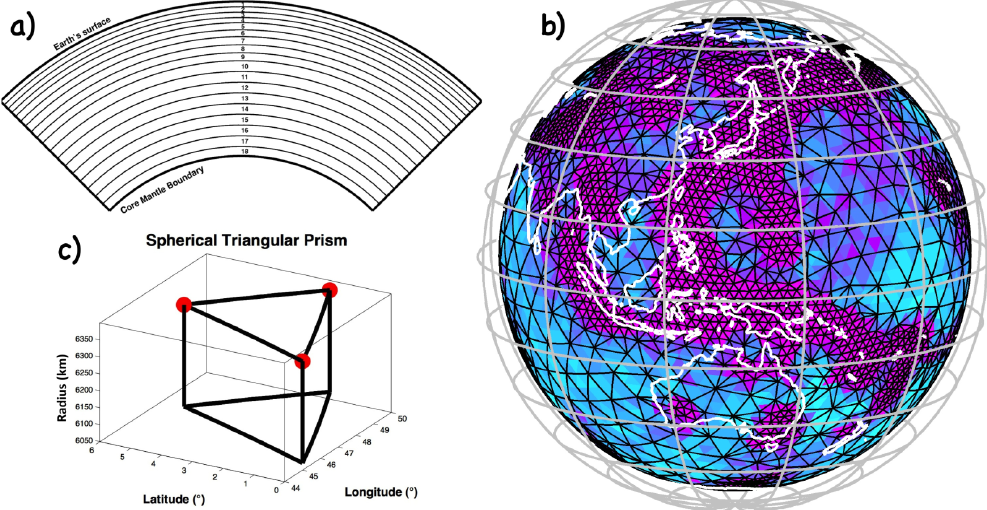
Fig. A1. Illustration of the model parameterisation. (a) 18 constant-depth spherical layers used for radially parameterising the mantle. (b) Optimised node distribution (black triangles mesh) obtained in one layer (530–660km depth). The nodes agency attempts to fit a “resolution length” function, ranging in this case from 210 (magenta) to 850km (cyan), that is driven by data coverage. (c) Representation of a spherical triangular prism, where the red dots represent three nodes of the model grid.